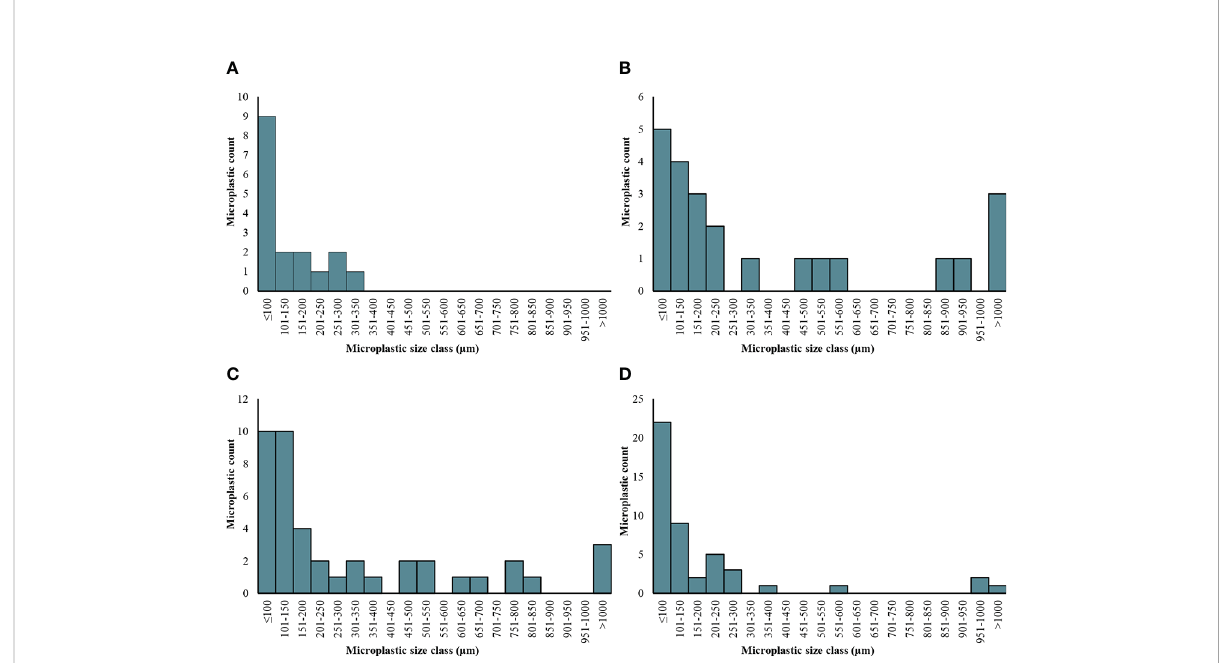
FIGURE 3 Size categories for microplastics found in soils with and without biosolid treatment in summer and winter [ (A) . No biosolids: summer; (B) Biosolids: summer; (C) No biosolids: winter; (D) Biosolids: winter]. Microplastic count represents the raw data and have not been blank